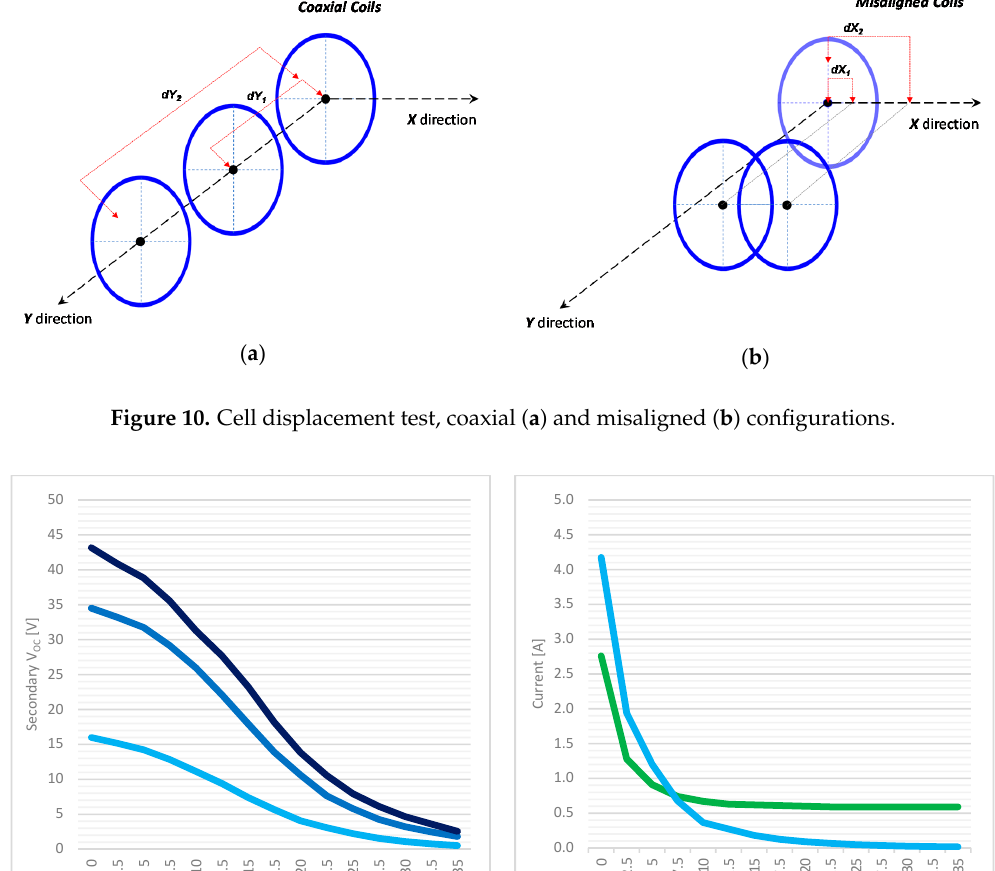
Figure 10. Cell displacement test, coaxial ( a ) and misaligned ( b ) configurations.